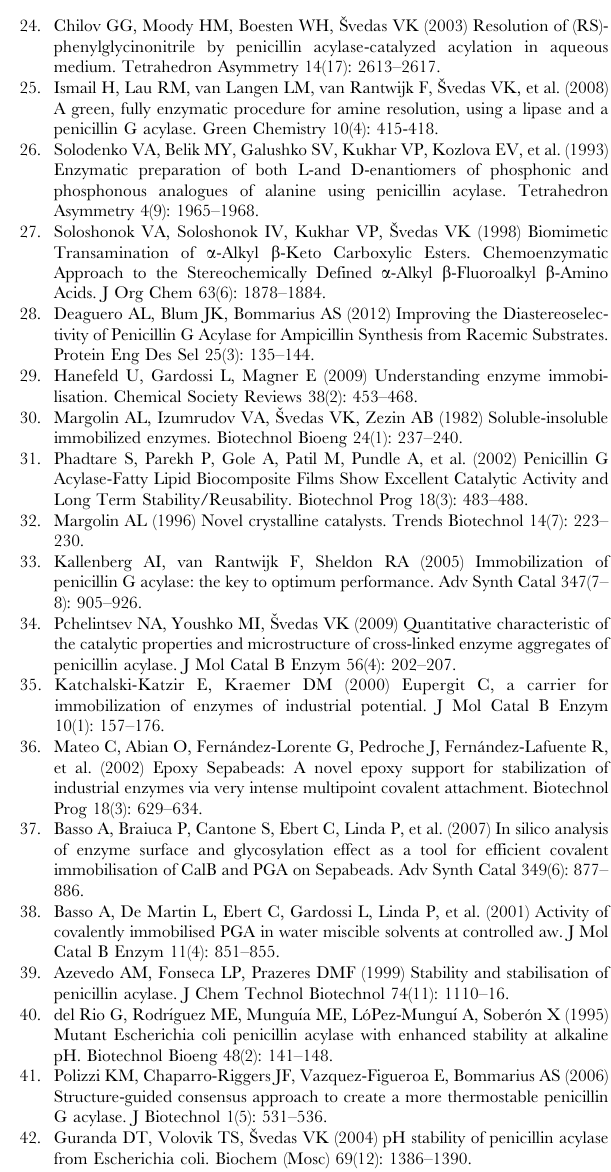
Table S1 Structural flexibility (RMSF) of wild type and mutant Ec PA at pH 7.5 and 10.0. RMSF for each variant has been averaged over three independent MD runs. The mean and standard deviation are shown in